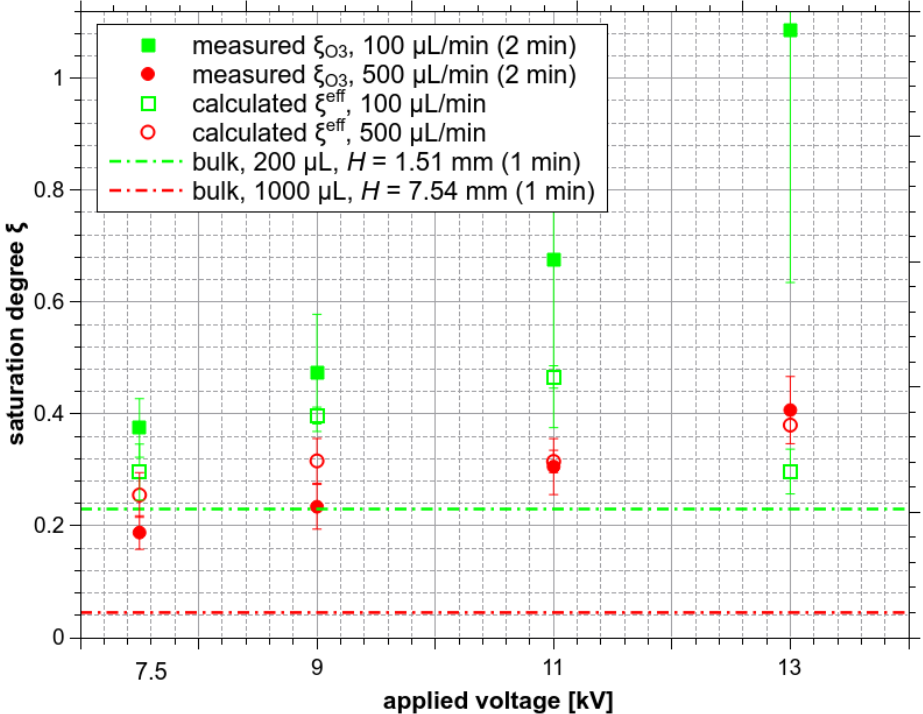
Figure 15. Comparison of O 3 ξ eff calculated from the size distribution histograms (Figure 5) of flying microdroplets with the measured ξ O3 of bottom microdroplets of two sets of ES experiments ( Q w = 100 and 500 µL/min), and O 3 saturation in the corresponding bulk experiments .